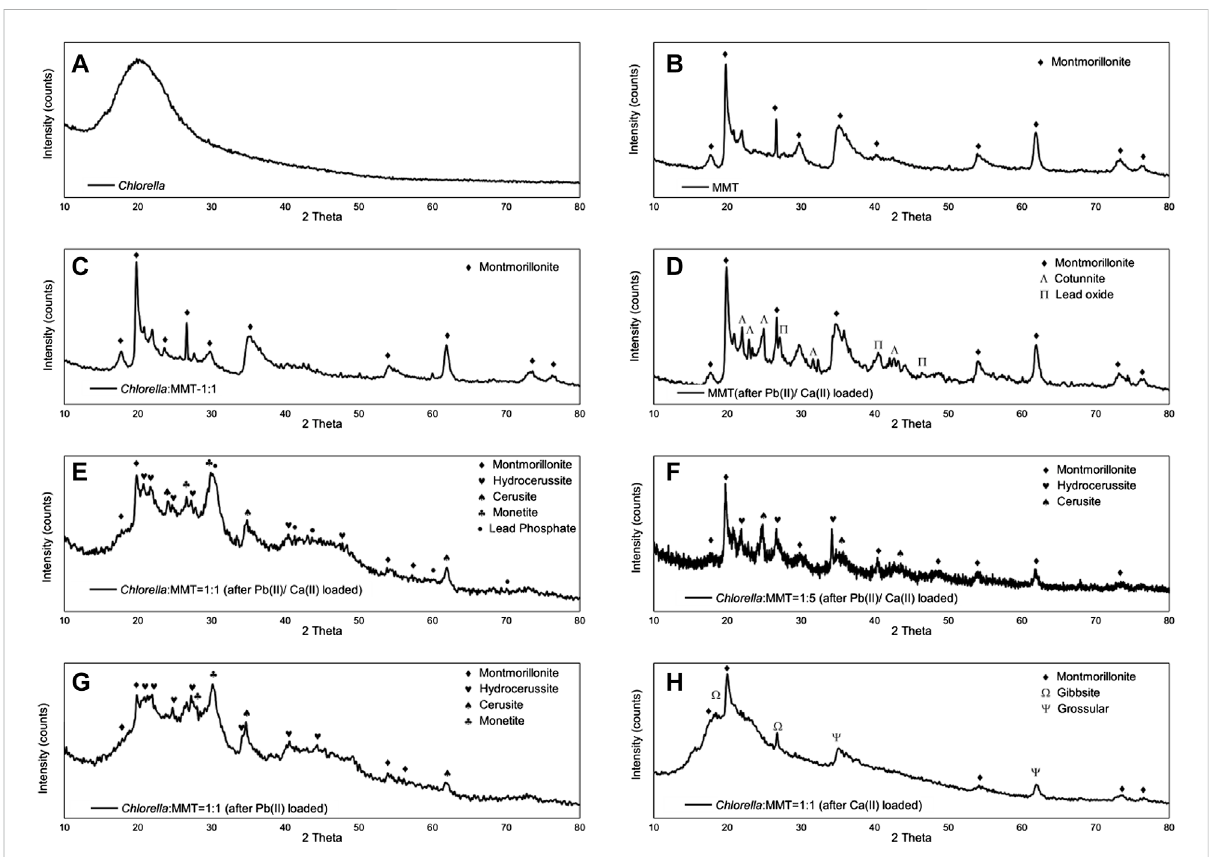
FIGURE 2 XRD spectra of (A) Chlorella ; (B) MMT; (C) Chlorella : MMT = 1:1; (D) MMT (after Pb(II)/Ca(II) loaded); (E) Chlorella : MMT = 1:1 (after Pb(II)/Ca(II) loaded); (F) Chlorella : MMT = 1:5 (after Pb(II)/Ca(II) loaded); (G) Chlorella : MMT = 1.1 (after Pb(II) loaded); and (H) Chlorella : MMT = 1:1 [after Ca(II)